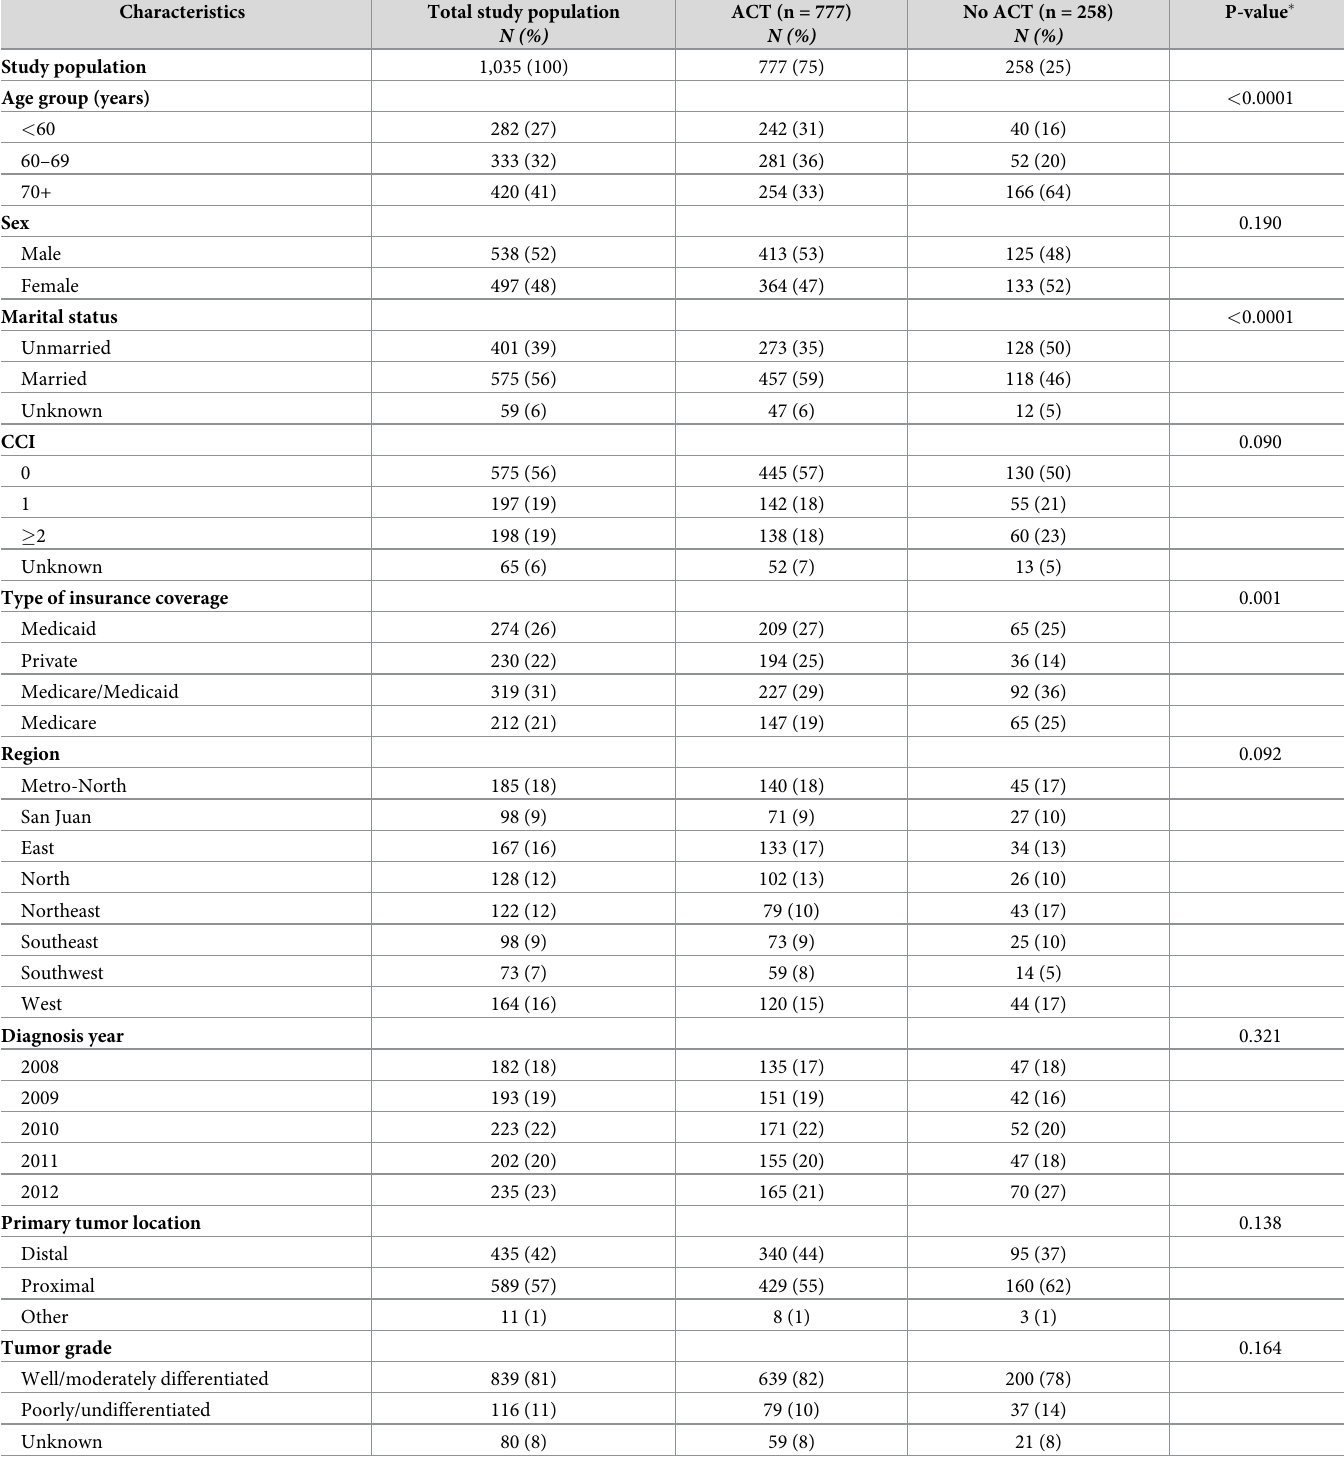
Table 2. Characteristics of stage III colon cancer patients by adjuvant chemotherapy (ACT)